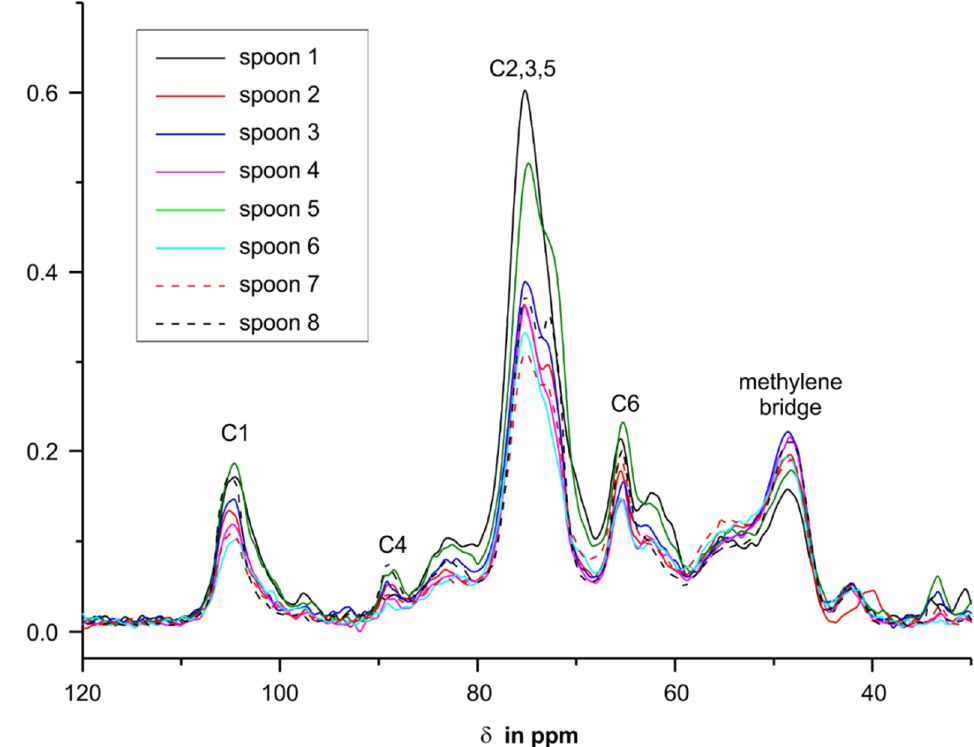
Figure 9. Section of the CP/MAS 13 C-NMR spectra of the spoons; all spectra are scaled to the intensity of the signal for triazine ring carbons at 168 ppm.